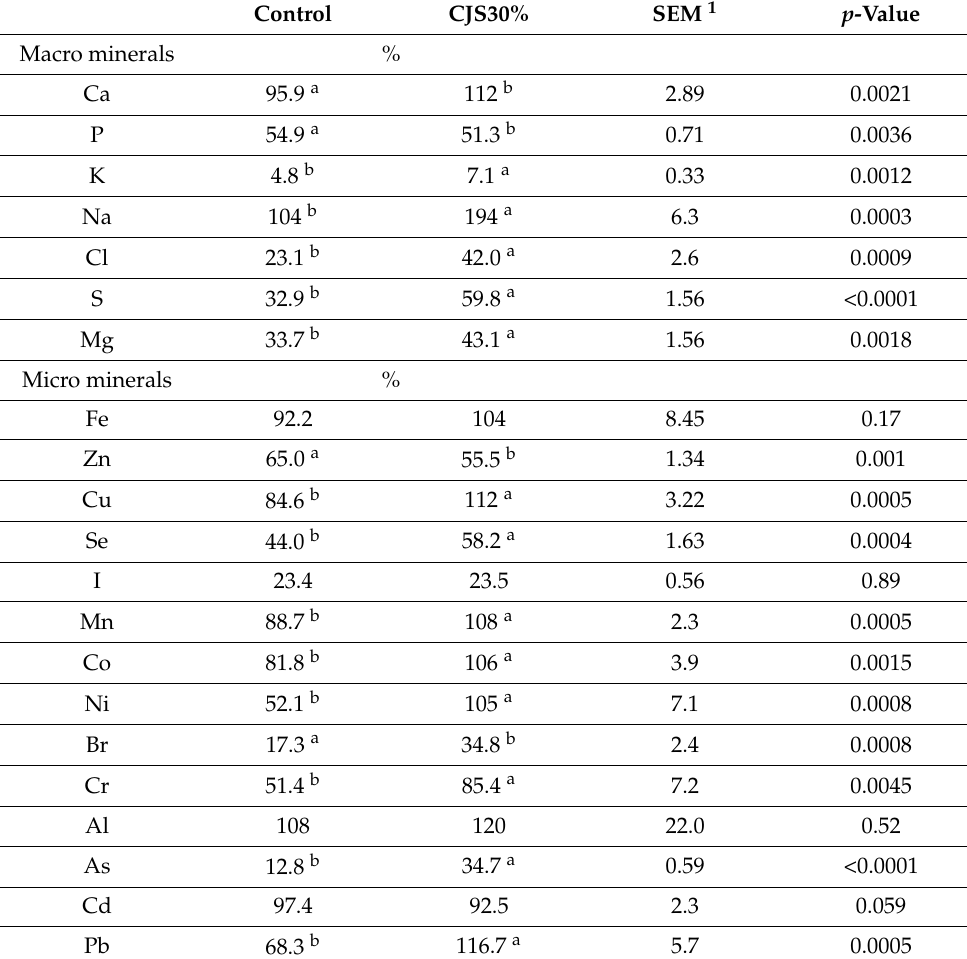
Table 4. Apparent fecal excretion (% of ingested) of minerals from the digestibility experiment with Atlantic salmon ( Salmo salar ) fed 30% Cyberlindnera jadinii (CJS, produced from S. latissima and woody